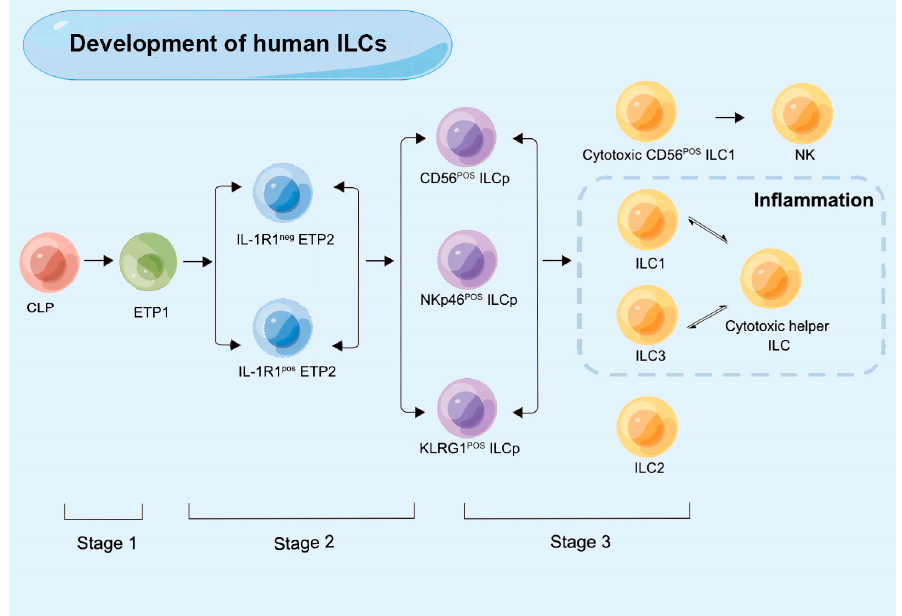
Figure 2. The development of human innate lymphoid cells (ILCs). CLP: common lymphoid progenitor; ETP: early tonsillar progenitors; ILCp: ILC precursor; KLRG: killer cell lectin-like receptor subfamily G member 1.